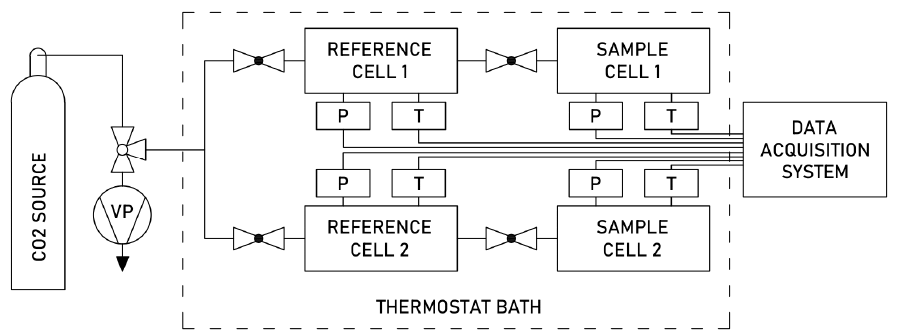
Figure 2. Schematic diagram of the laboratory pressure stand for measuring the adsorption equi- libriums of porous materials.